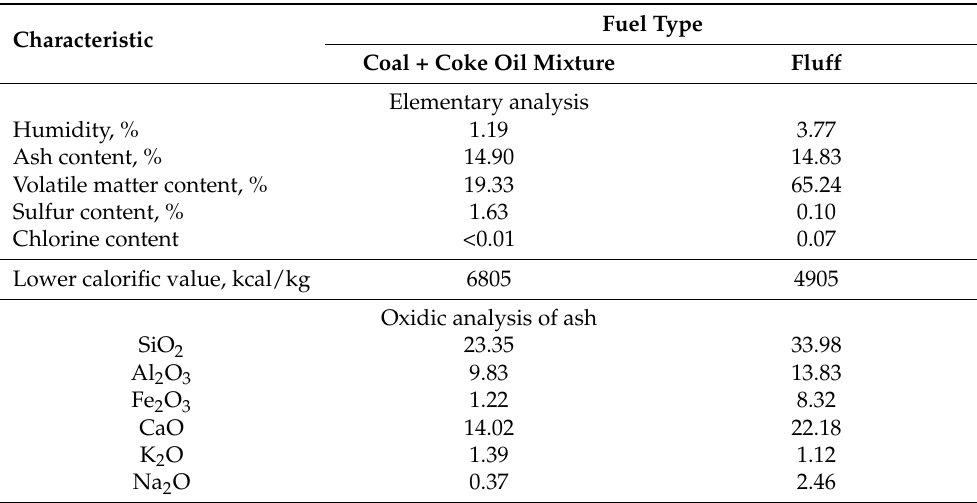
Table 4. The characteristics of the fuels used in the combustion process of the clinker.